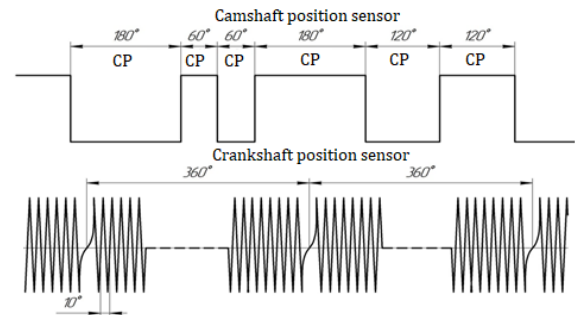
Figure 3. Crankshaft position sensor and camshaft position sensor signals on Toyota 2GR-FE (CP – crankshaft positi– on)